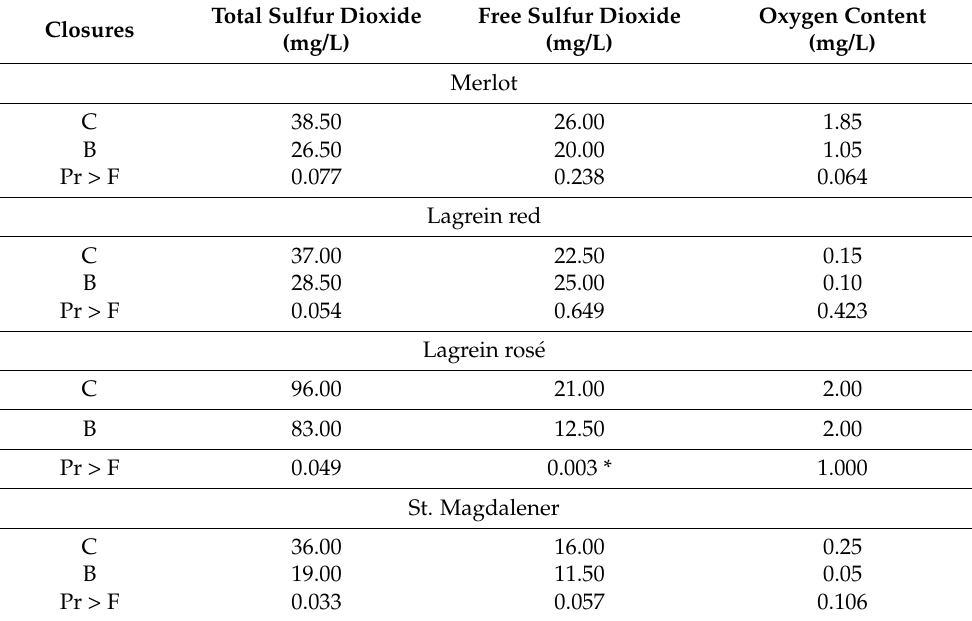
Table 5. One-way ANOVA for dissolved oxygen, free and total sulfur dioxide content of wines stored for 30 months and closed with blend closures. Pr > F indicates the p -value associated with the F statistic. The asterisk (*) means significantly different groups as determined by Tukey’s test ( α < 0.01). B and C: blend and conventional closure,